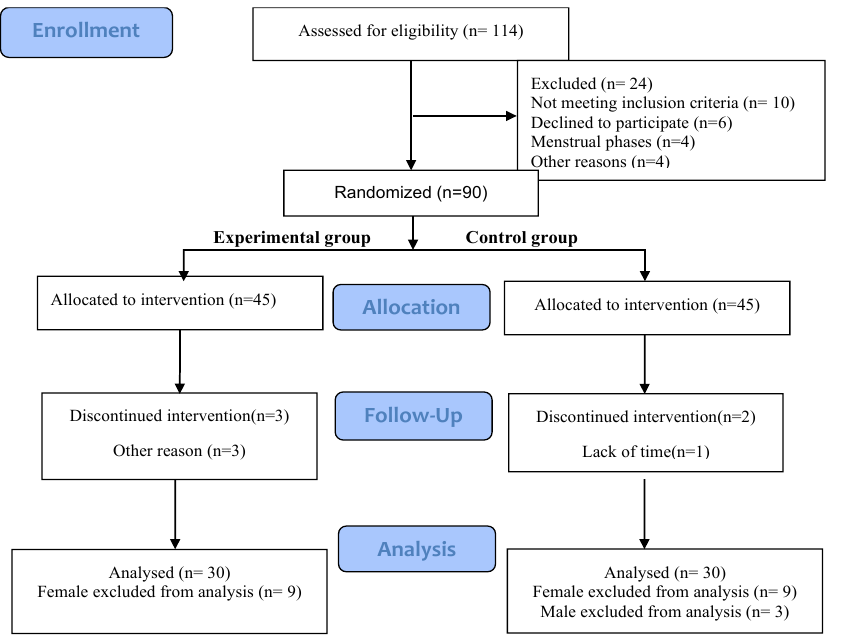
Figure 1. CONSORT Flow Diagram.